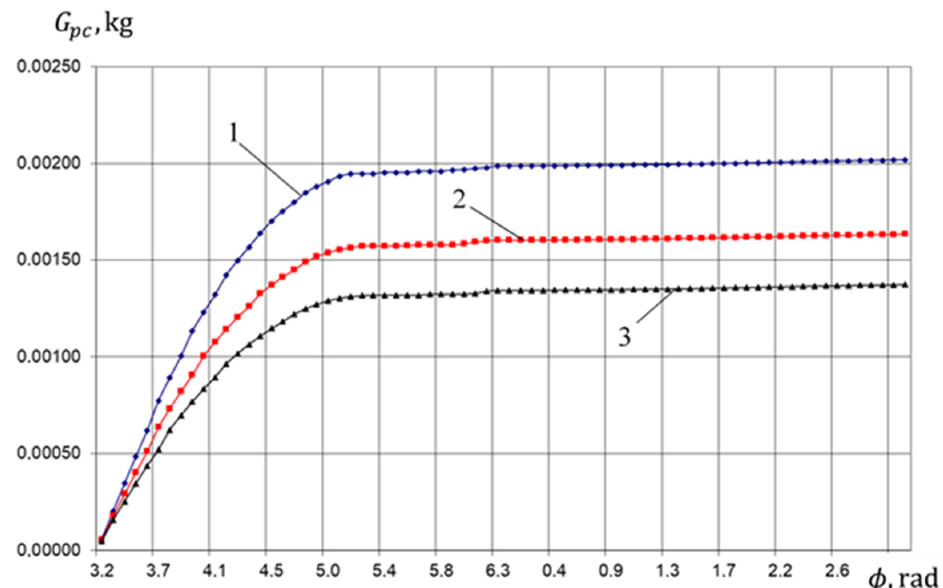
Figure 22. The dependence of the total liquid flow from the pump section to the compressor section on the angle of rotation of the crankshaft at different speeds (1— n rev = 400 rpm; 2— n rev = 500 rpm; 3— n rev = 600 rpm).